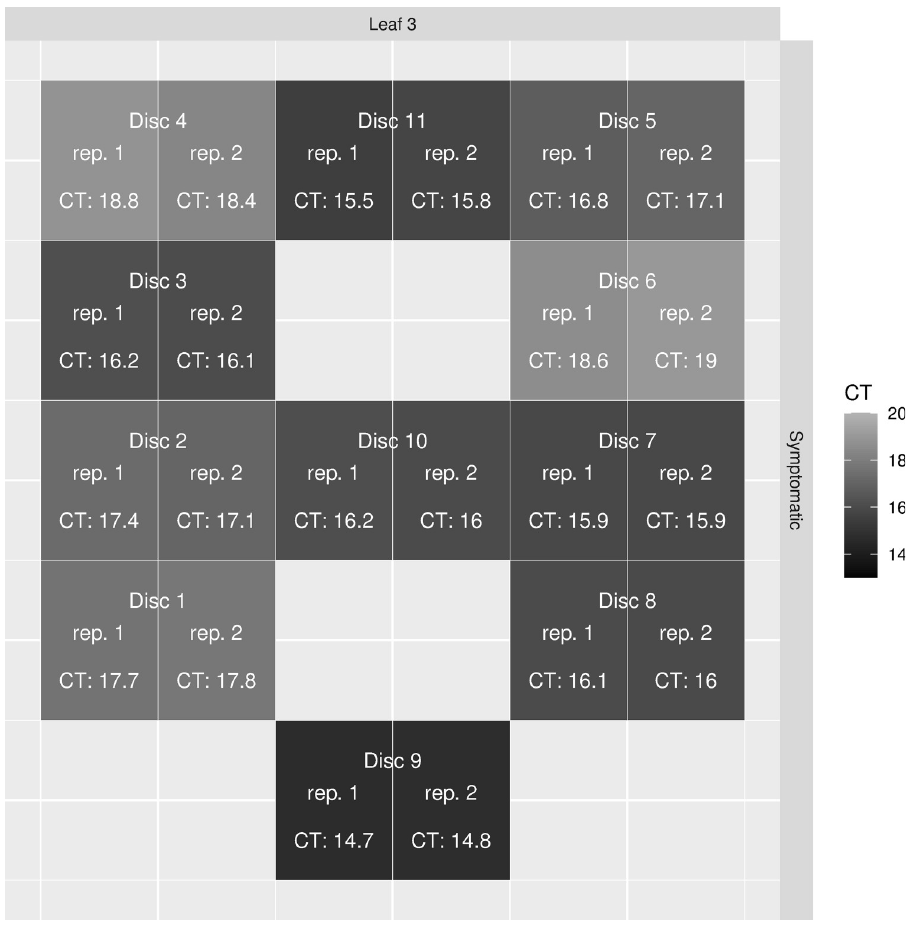
Fig 2. Heatmap representation of Ct values from duplicate RT-qPCR assays of each disc for a specific leaf.